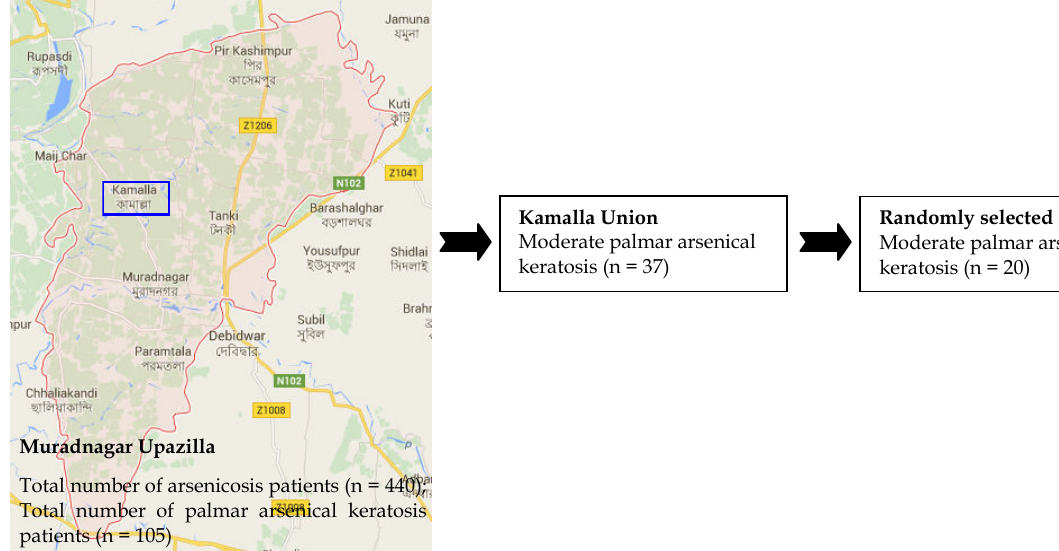
Muradnagar Upazilla Total number of arsenicosis patients (n = 440); Total number of palmar arsenical keratosis patients (n = Figure 1: Selection of patients